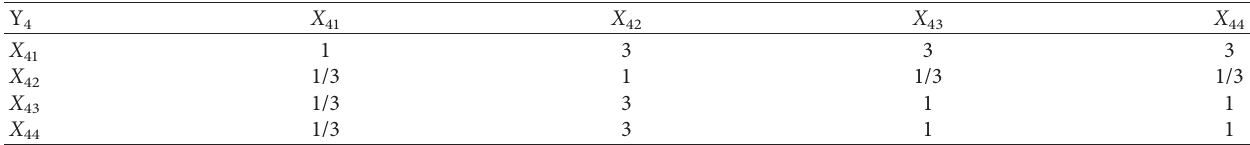
Table 8: Judgment matrix of the construction